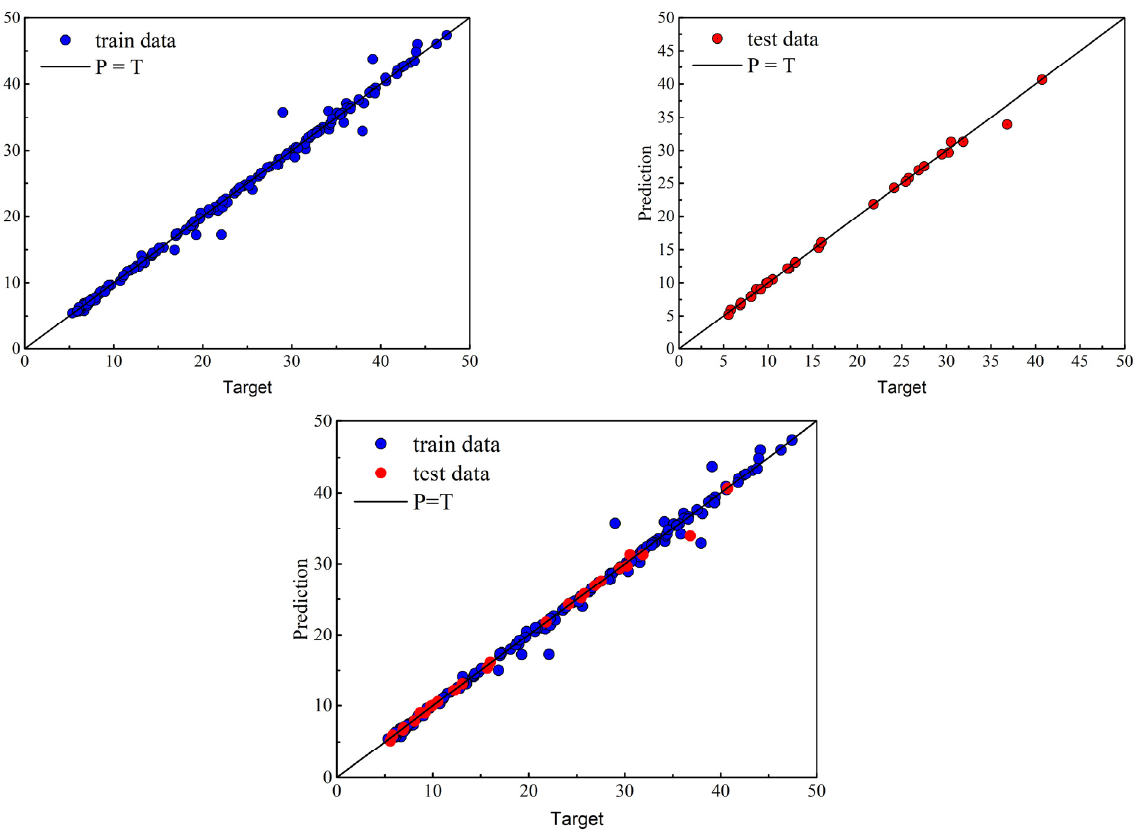
Figure 3. The Q–Q plots of the relationships between the actual and predicted hardness values of the log samples.